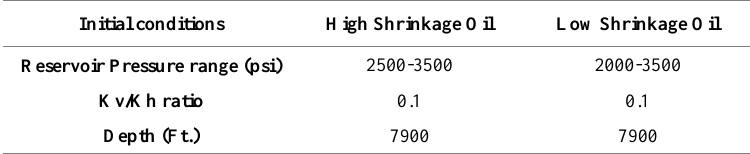
Table 4. Initial conditions used for simulation Models